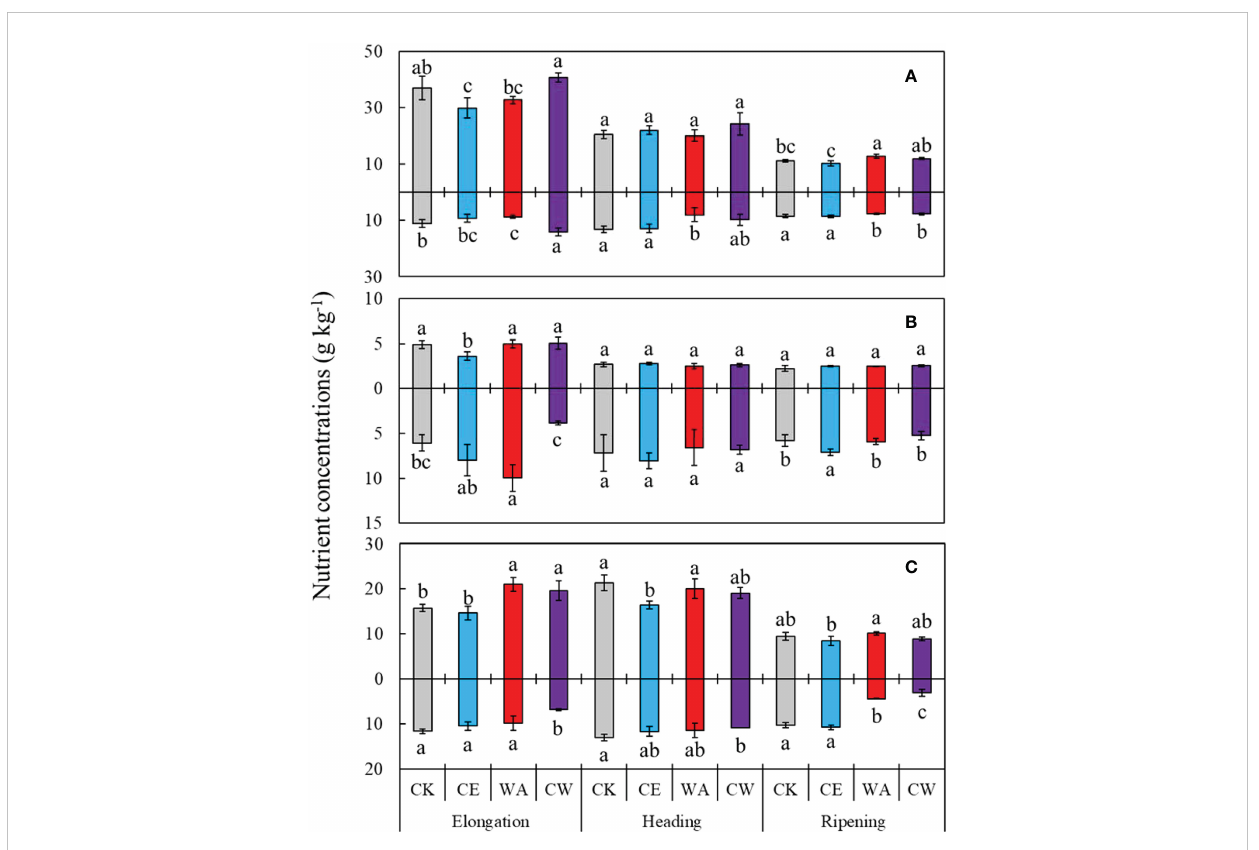
FIGURE 1 Nitrogen (A) , phosphorus (B) , and potassium (C) Concentrations in plant shoots (upper) and roots (lower) under ambient condition (CK), elevated [CO 2 ] alone (CE), canopy warming alone (WA) and combined treatment (CW). Different letters indicate signi fi cant differences between treatments in the same stage at P < 0.05.